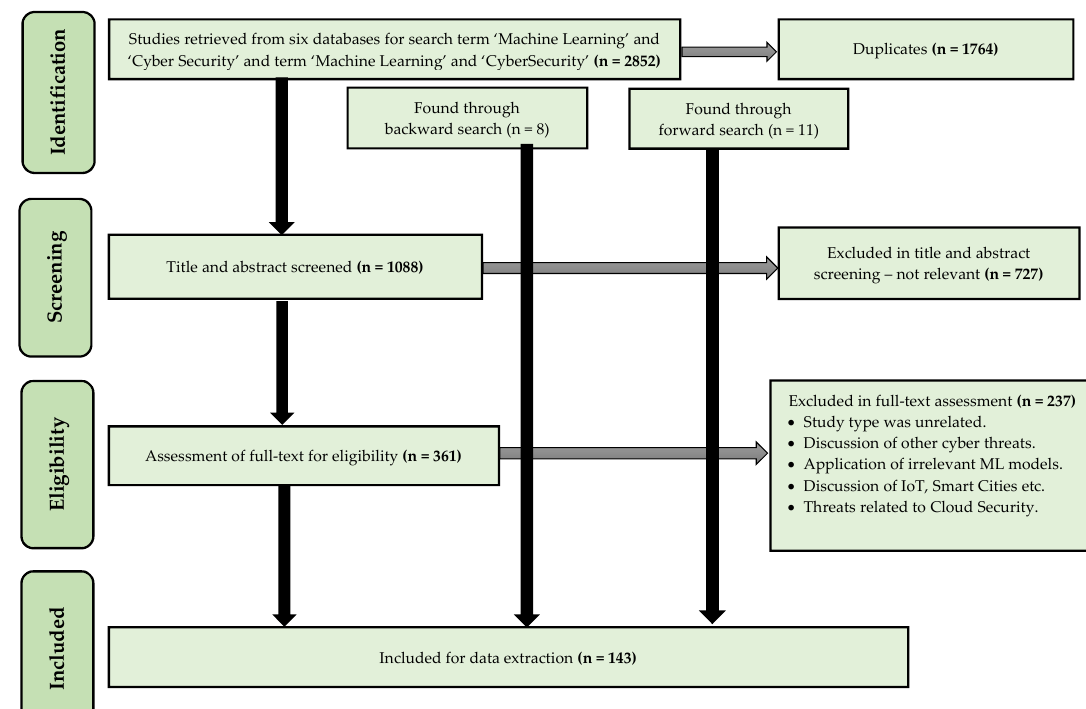
Figure 1. Flow Diagram Showing Article Selection Process for This